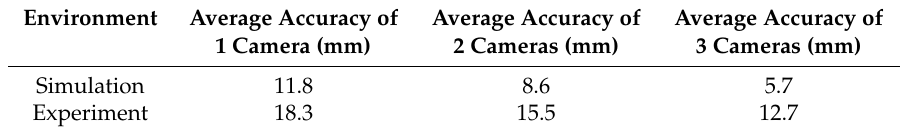
Table 2. Comparison of average accuracy error of detection in simulation with the single robot vs. real